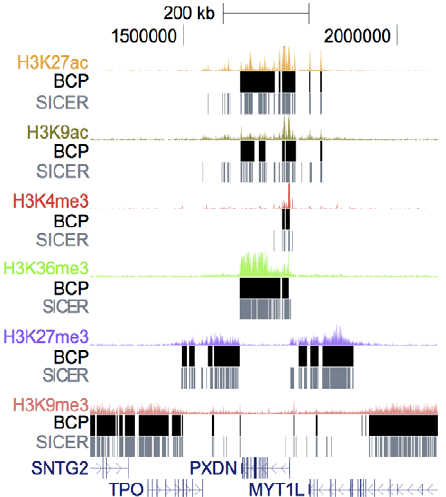
Figure 4. BCP dynamically adapted to many different types of data. To demonstrate its versatility, we compiled a set of several histone modifications and analyzed each under the default parameters for BCP and SICER. Regardless of the histone mark characteristics, whether more punctate as in acetylation marks and H3K4me3 or broad as in H3K27me3, H3K36me3, and H3K9me3, BCP (black) was able to make reasonable island calls that effectively described the underlying read profiles. SICER (grey) seemed more primed to identify smaller, sharper islands so often fragmented more general regions of